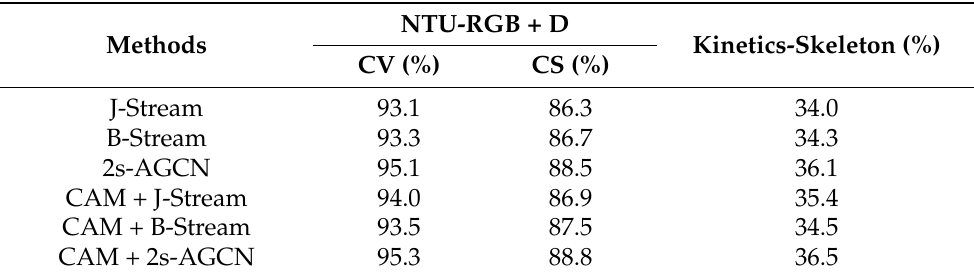
Table 1. Effectiveness analysis of coordination attention module on NTU-RGB + D and Kinetics- Skeleton